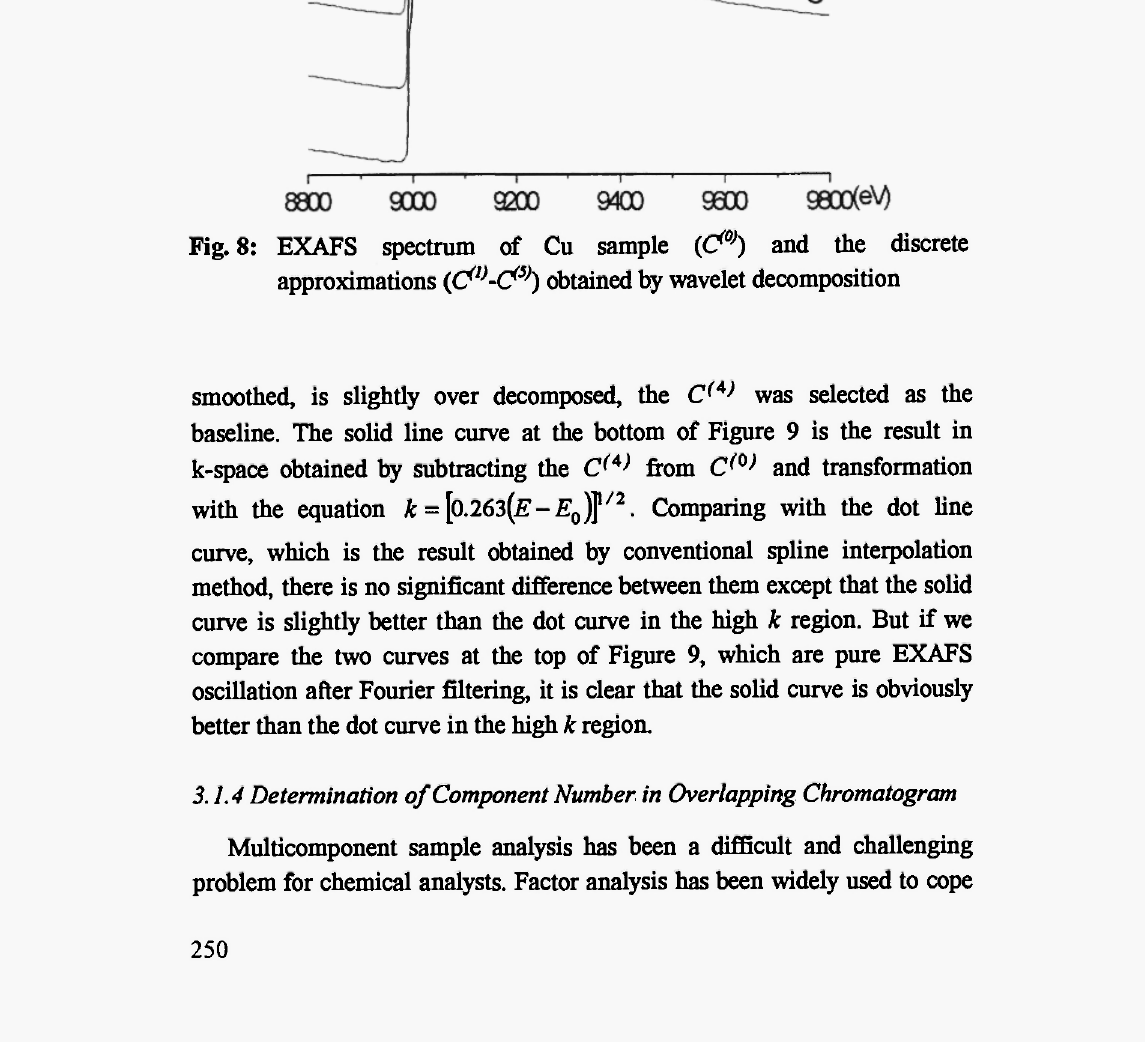
Fig. 8: EXAFS spectrum of Cu sample (C o; ) and the discrete approximations (0 1} -d 5> ) obtained by wavelet decomposition